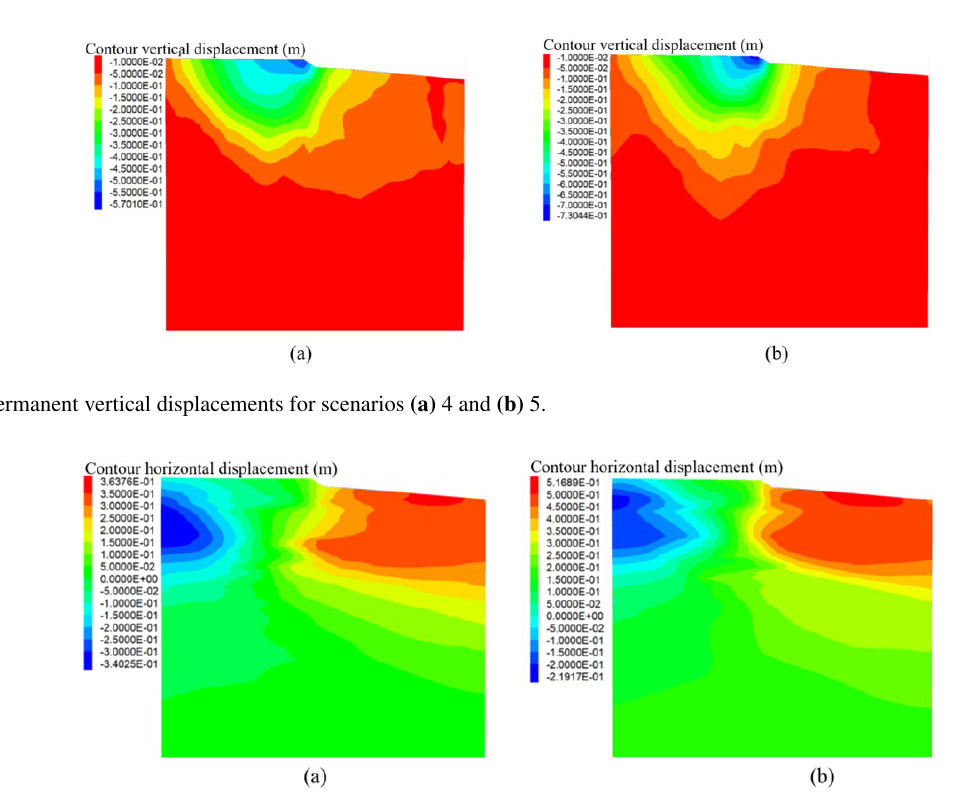
Figure 21. Permanent horizontal displacements for scenarios (a) 4 and (b) 5.